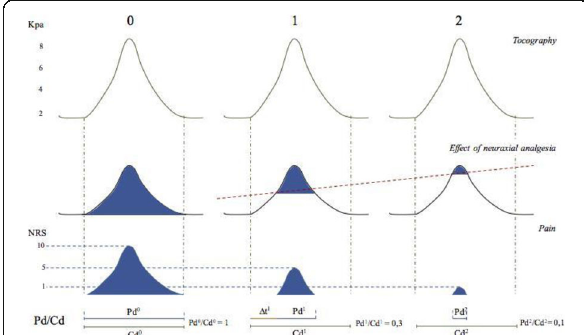
Fig. 1 (abstract A158). Variables to be studied and hypothetical interplays and interactions between them: 0 basal condition; 1, 2: